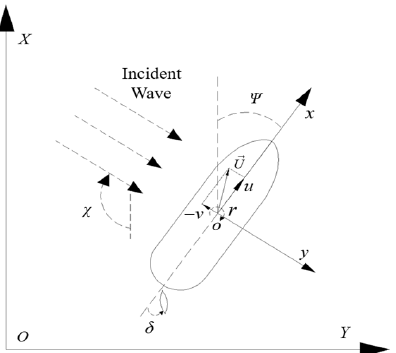
Figure 2. Space fixed coordinate system and ship moving coordinate system.